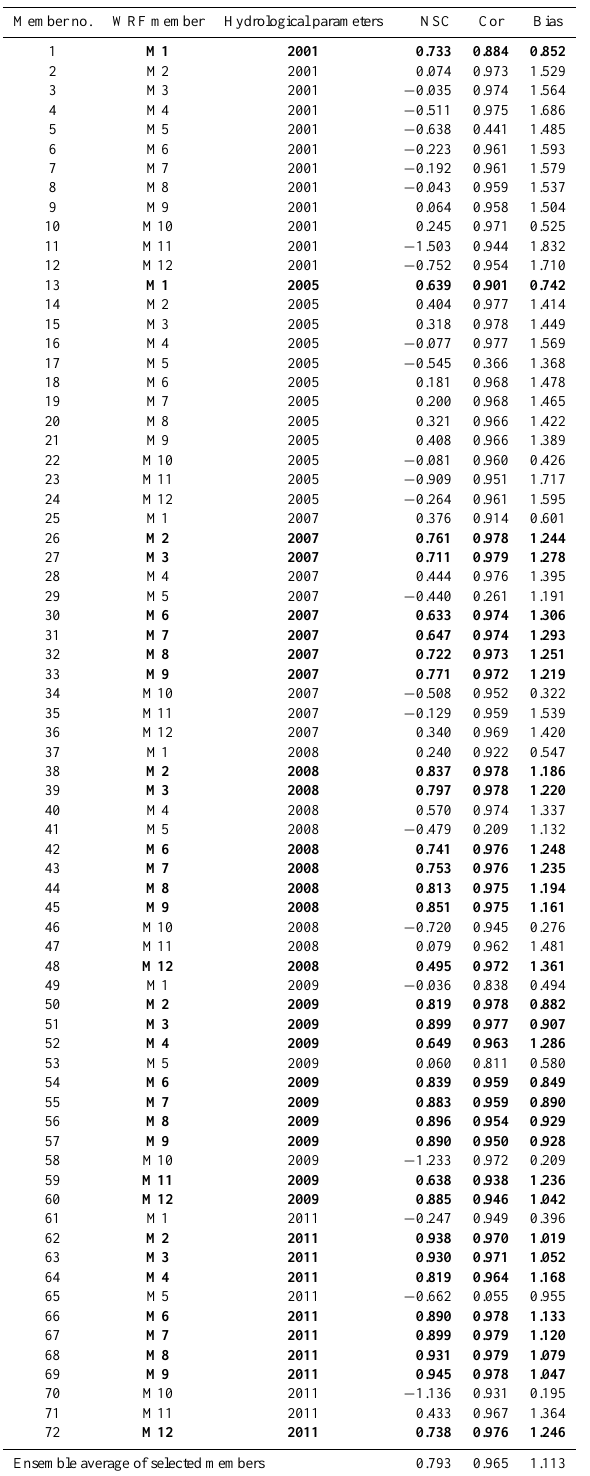
Table 4. Error metrics in the estimation of river discharge by the rainfall–runoff model using six parameter sets and 12 members of the multi-physics ensemble (those selected are shown in bold with NSC > 0.6 and Cor > 0.7).